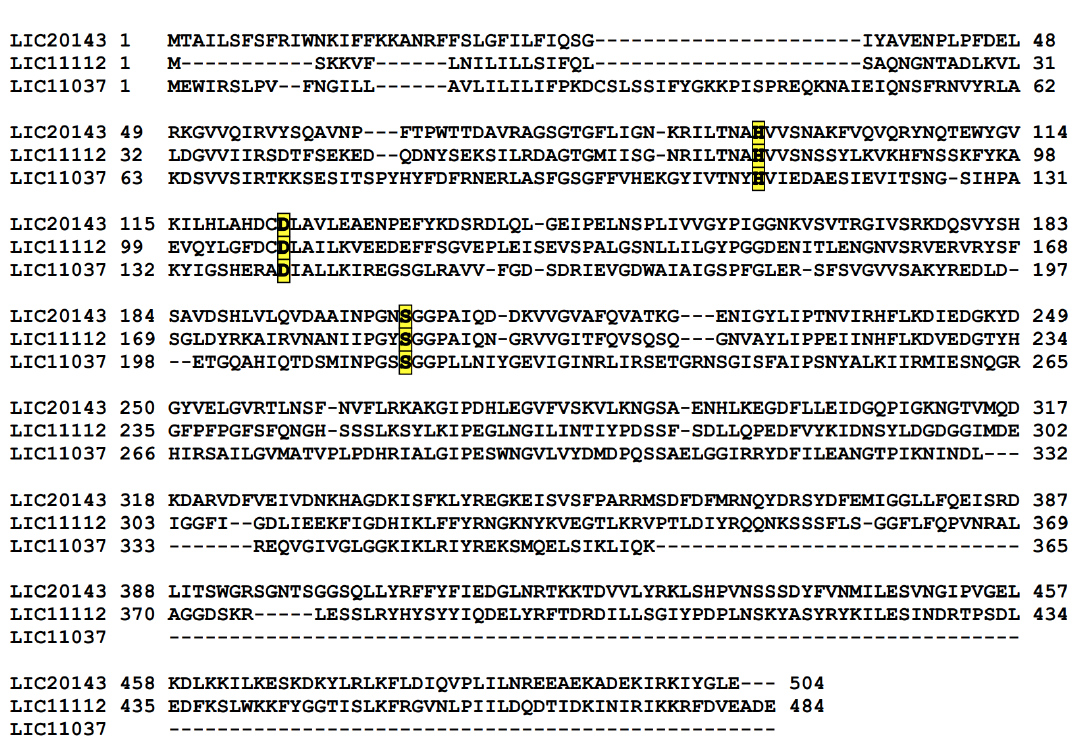
Figure 7. Alignment of the LIC20143, LIC11112, and LIC11037 of L. interrogans serovar Copenhageni. Alignment was done using the PROMALS3D tool, which aligns the sequences considering the amino acid sequence and protein domains. The amino acids histidine (H), aspartic acid (D) and serine (S) are highlighted showing that they are conserved in these three proteins.